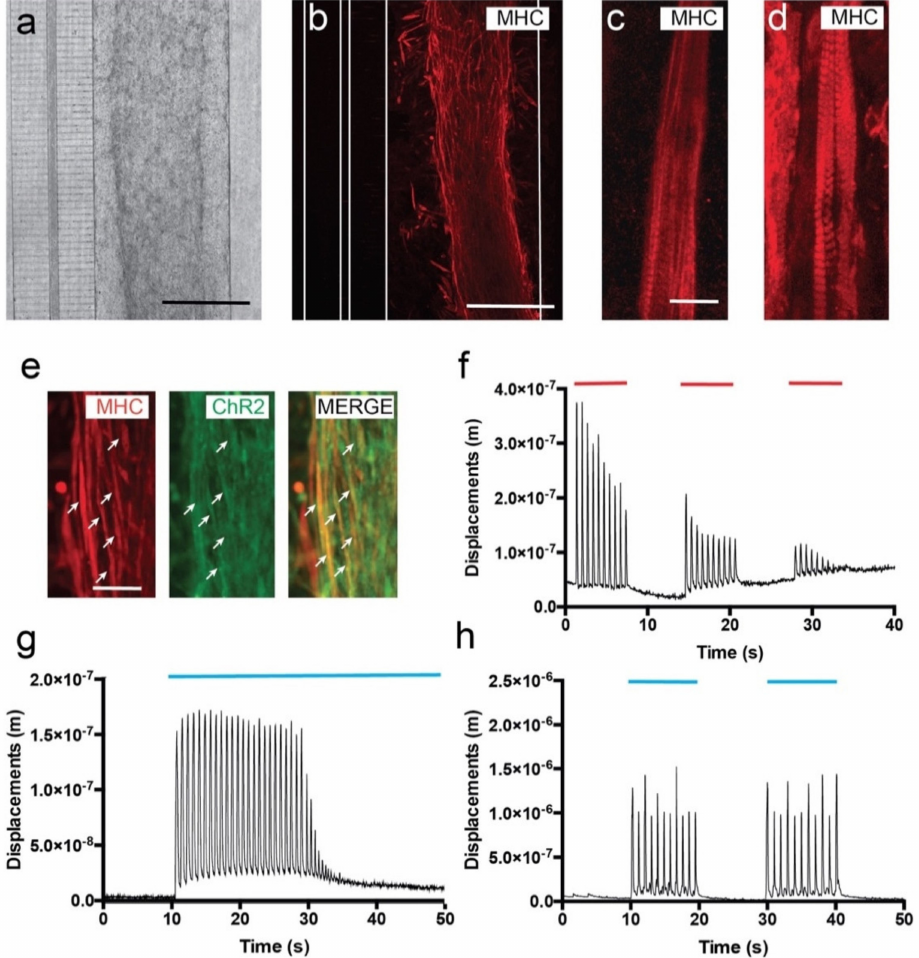
Figure 2. Development and functional properties of cultured C2C12-ChR2 cells in microfluidic devices. ( a ) Low magnification phase contrast ( a ) and fluorescence after the immunohistochemical detection of the MHC ( b ) micrographs illustrating di ff erentiating C2C12 myoblasts in the right chamber 3 days after seeding. As a result of the fixation and the immunohistochemical procedure, a shrinkage of the hydrogel could be observed. Please note that the connecting microchannels and the transversal axotomy channel can be seen on the left in ( a ). The microfluidic limits of these microchannels are labelled as white lines in ( b ). ( c , d ) Myotube di ff erentiation of C2C12-ChR2 myoblasts at di ff erent in vitro timepoints: 3 ( c ) and 7 days ( d ). Note the increasing presence of the MHC-positive labelling of sarcomers in the di ff erentiating myotubes in ( d ) with respect to ( c ). ( e ) Fluorescence photomicrographs illustrating double-labelled (ChR2-MHC, arrows) di ff erentiating myotubes in the chamber. ( f ) Graph illustrating one example of the displacement measurements ( y -axis) of di ff erentiated C2C12-ChR2 myotubes after electrical activation (red lines) over time ( x -axis). ( g , h ) Graphs illustrating one example of the displacement measurements ( y -axis) of di ff erentiated C2C12-ChR2 myotubes after optogenetic activation (blue) in continuous ( g ) or pulsatile ( h ) illumination (blue lines in g and h) (see Material and Methods for details of analysis and Results for the statistical analysis). Scale bars: (a,b) = 100 µ m, (c) = 50 µ m, (e) = 25 µ